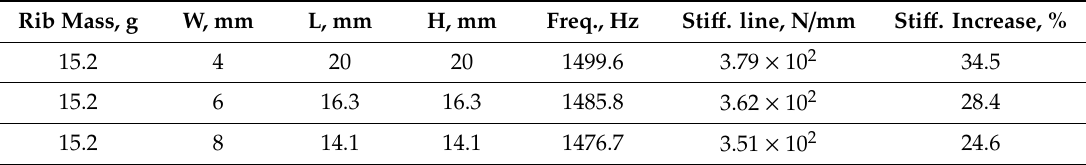
Table 6. Results of parameter study 1.